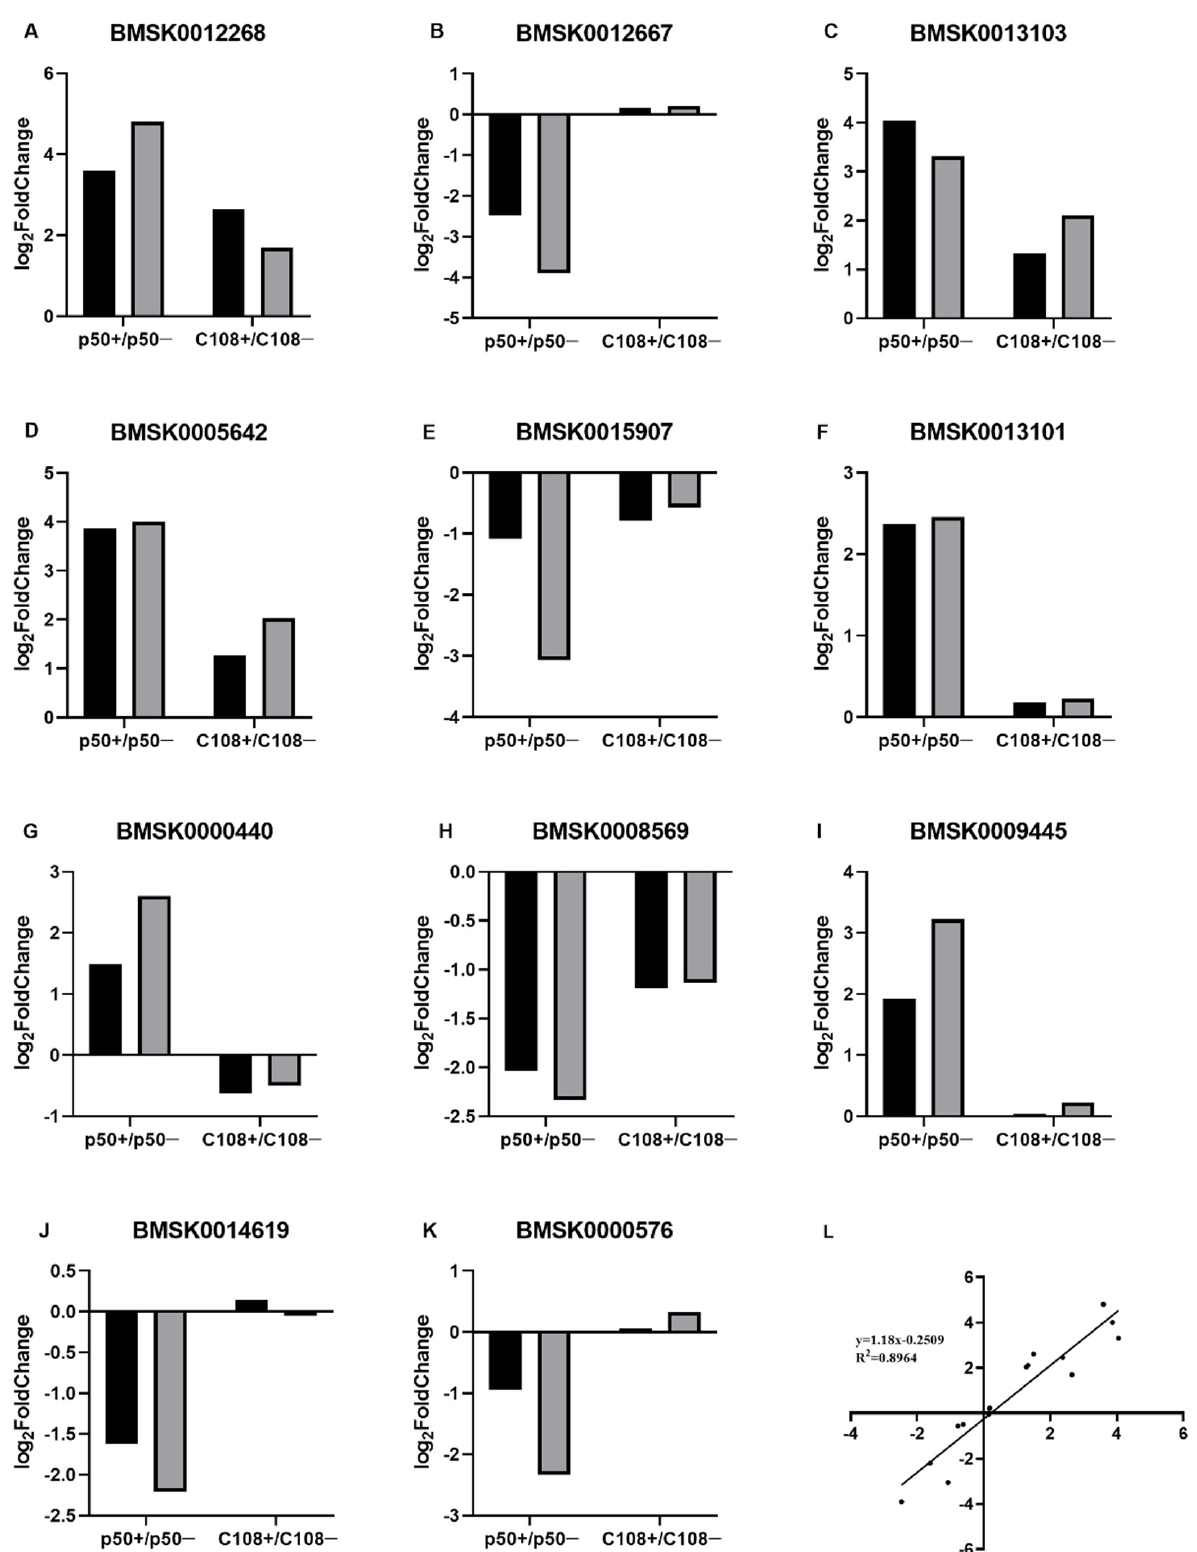
Figure 2. Correlation analysis between gene expression ratios obtained from transcriptome data and RT-qPCR. ( A – K ) Expression ratios (log 2 fold change) were obtained from RT-qPCR and transcriptome data. ( L ) Lineage analysis between the transcriptome and RT-qPCR. The ratios obtained by RT-qPCR ( x -axis) were plotted against the ratios obtained by RNA-Seq ( y -axis).